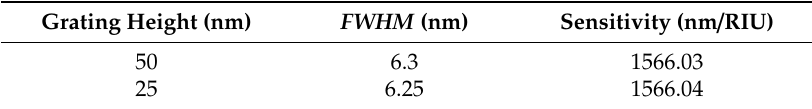
Table 3. Simulated sensitivity and FWHM for di ff erent grating’s